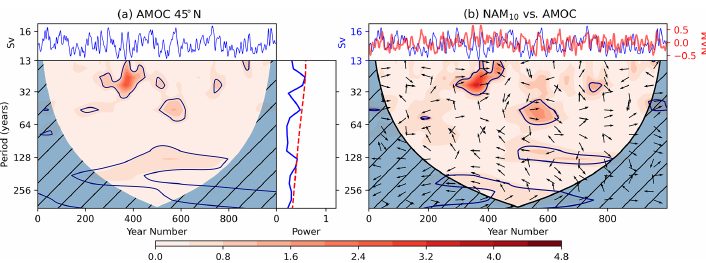
Figure A2. Same as Fig. 8 but for the AMOC at 45 ◦ N. Panel (a) shows the wavelet power spectrum of the NAO, and panel (b) shows the cross-power spectrum between the AMOC and the NAM 10 index.